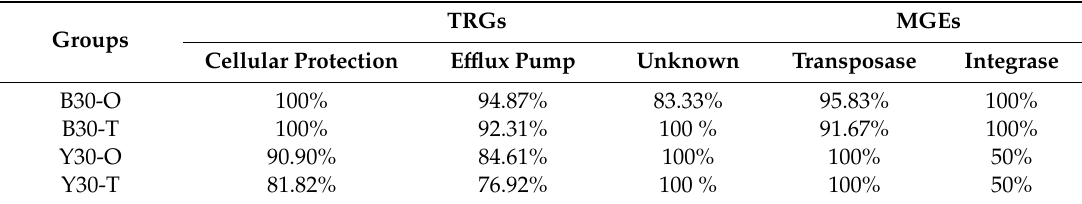
Table 1. Detection rate of TRGs and MGEs belonging to di ff erent mechanisms. B30-O and Y30-O stand for original soil samples, whiles B30-T and Y30-T stand for soil samples collected on day